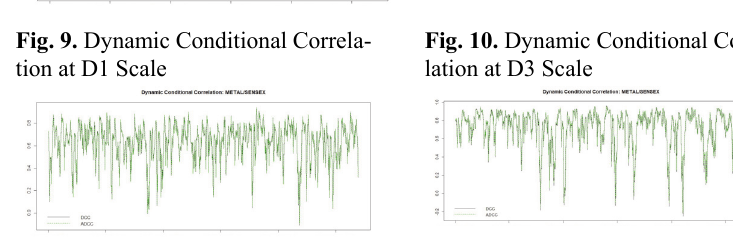
Fig. 13. Dynamic Conditional Corre- lation at D3 Scale